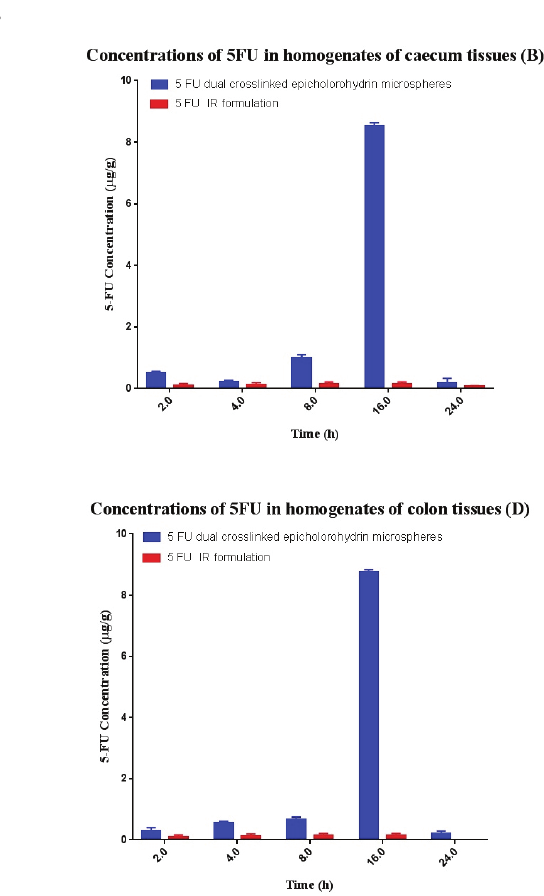
Figure 4: Concentration of un-encapsulated ad encapsulated 5-FU in homogenates of: (A) caecum content; (B) caecum tissue; (C) colon content; and (D) colon tissue after oral administration of the formulations. Data are mean ± s.d.